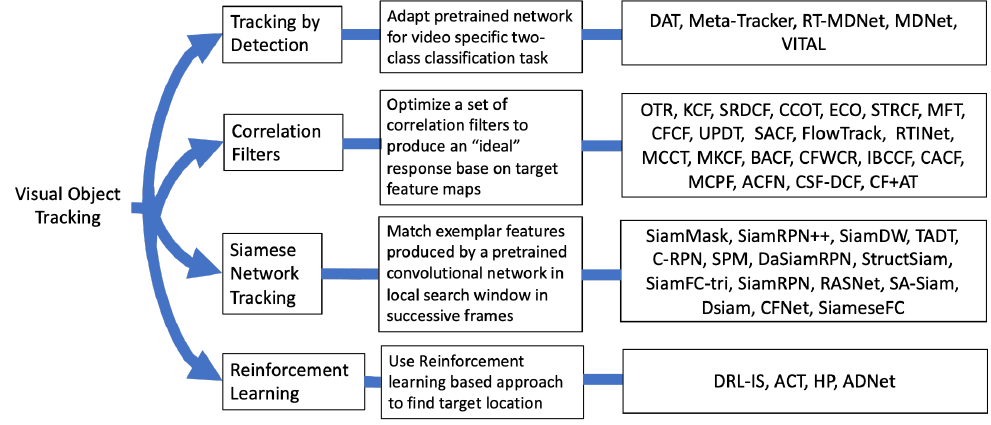
Figure 1. Grouping of convolutional neural network (CNN)-based visual object tracking